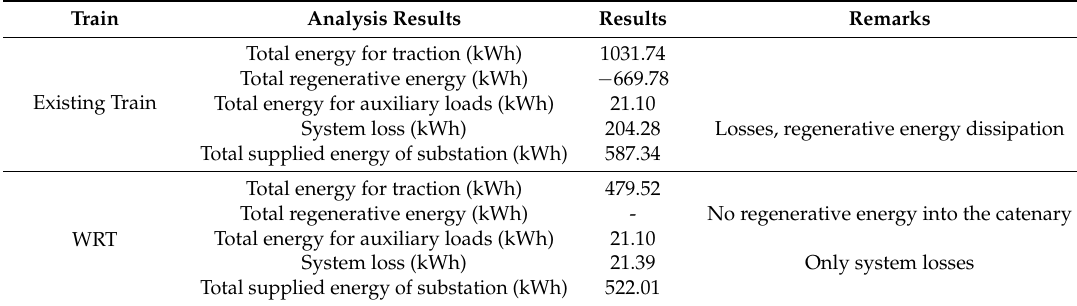
Table 4. Train energy analysis results at peak headway condition.